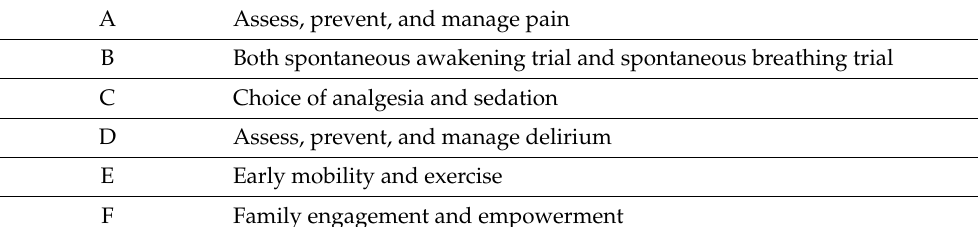
Table 6. ABCDEF bundle. A Assess, prevent, and manage pain B Both spontaneous awakening trial and spontaneous breathing trial C Choice of analgesia and sedation D Assess, prevent, and manage delirium E Early mobility and exercise F Family engagement and